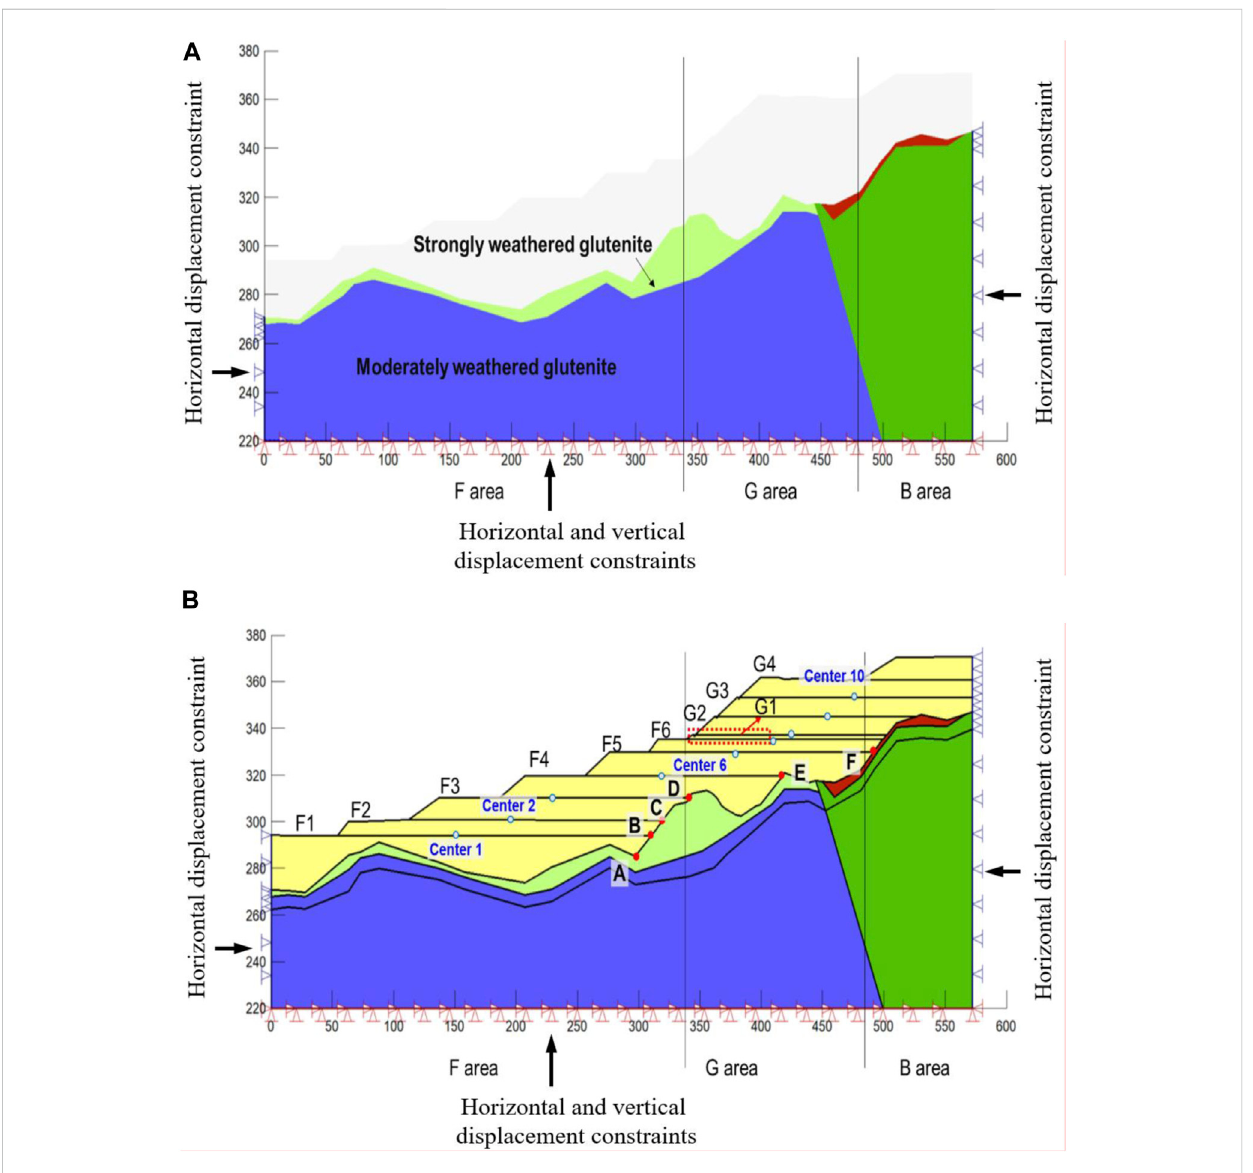
FIGURE 4 Numerical model at the (A) initial state; (B) after fi